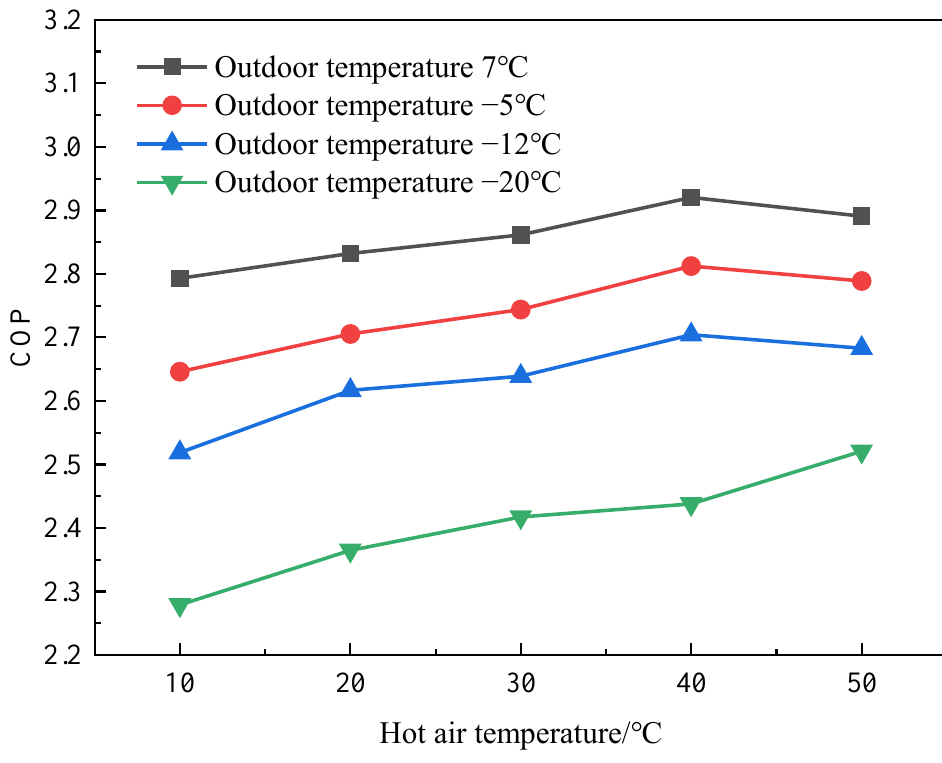
Figure 10. COP of the system.